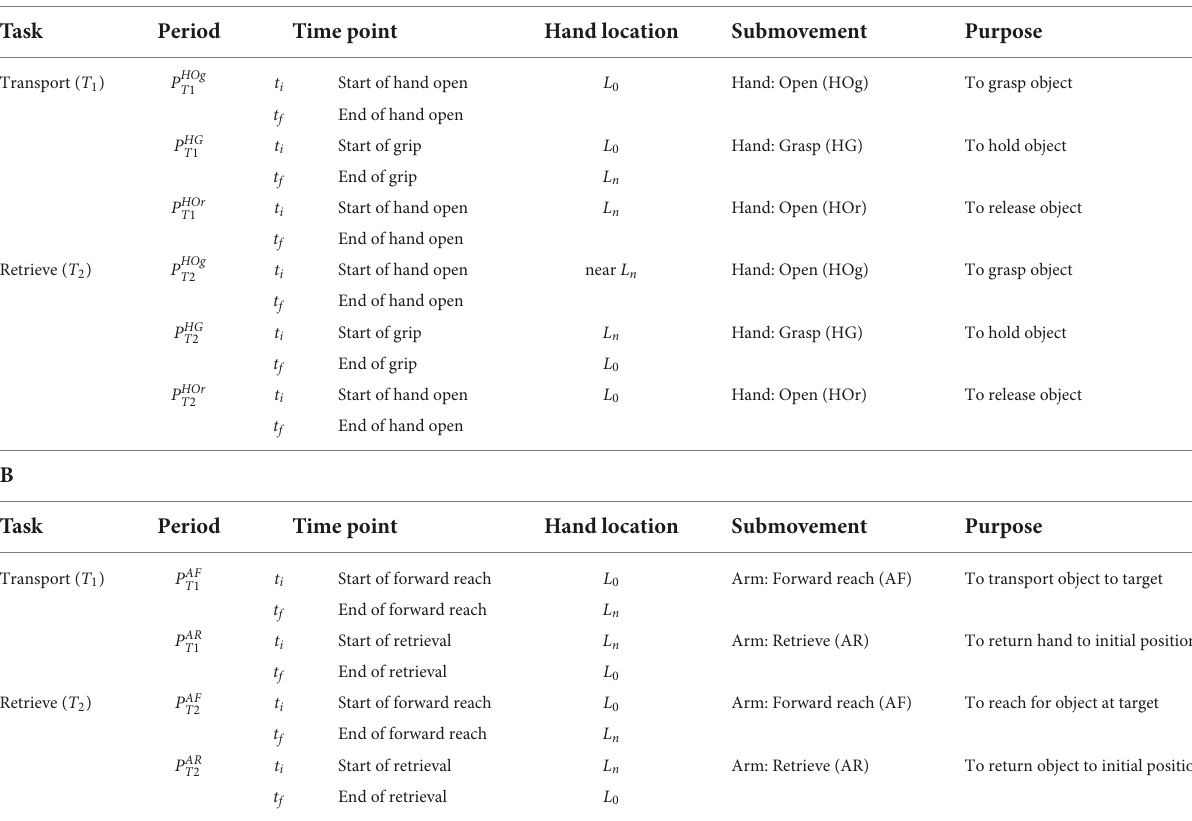
TABLE 2 Definition of time points and periods: (A) Hand movement periods and time points. (B) Arm movement periods and time